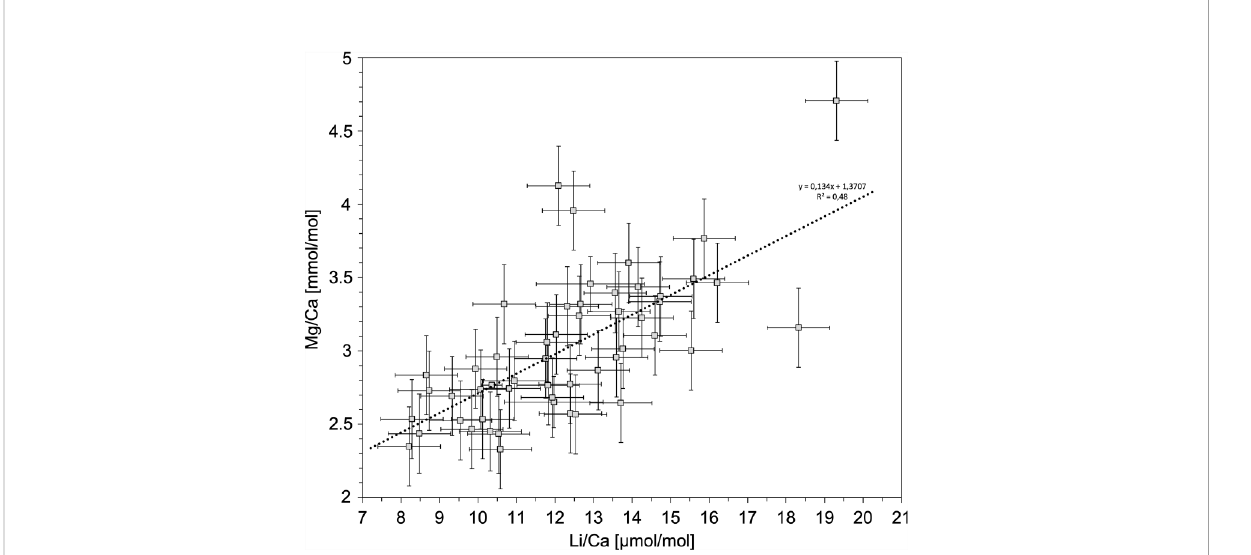
FIGURE 8 All samples exhibit a correlation of Mg/Ca and Li/Ca in S. variabilis, which is shown by the dotted line. Uncertainties are indicated in